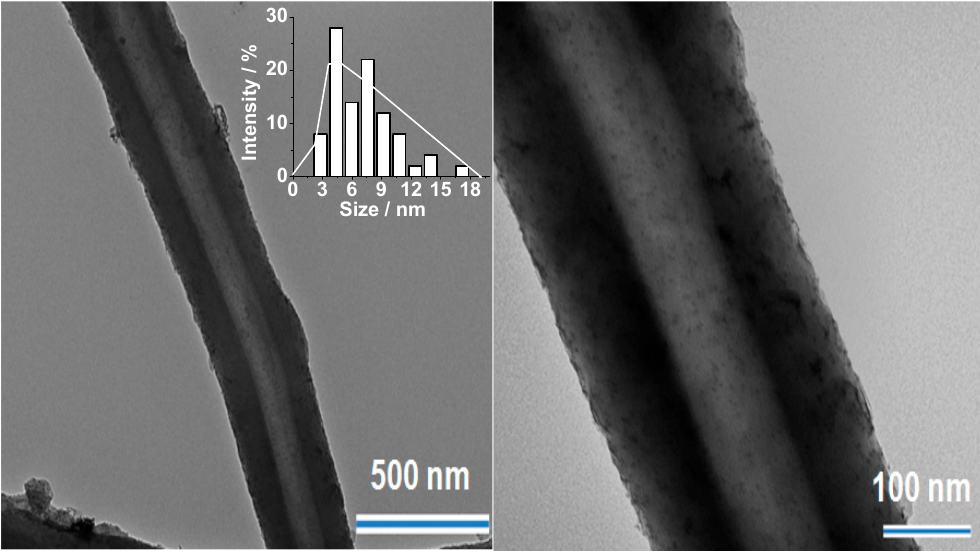
Figure 2. TEM images of Pd/PP ‐ 3.